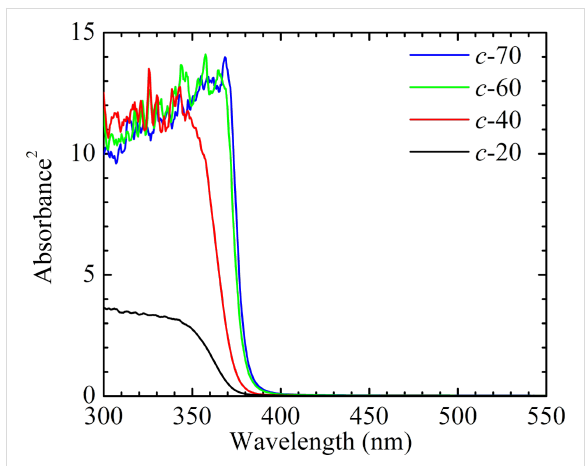
Figure 5: Absorbance (squared) of the four ZnO@B